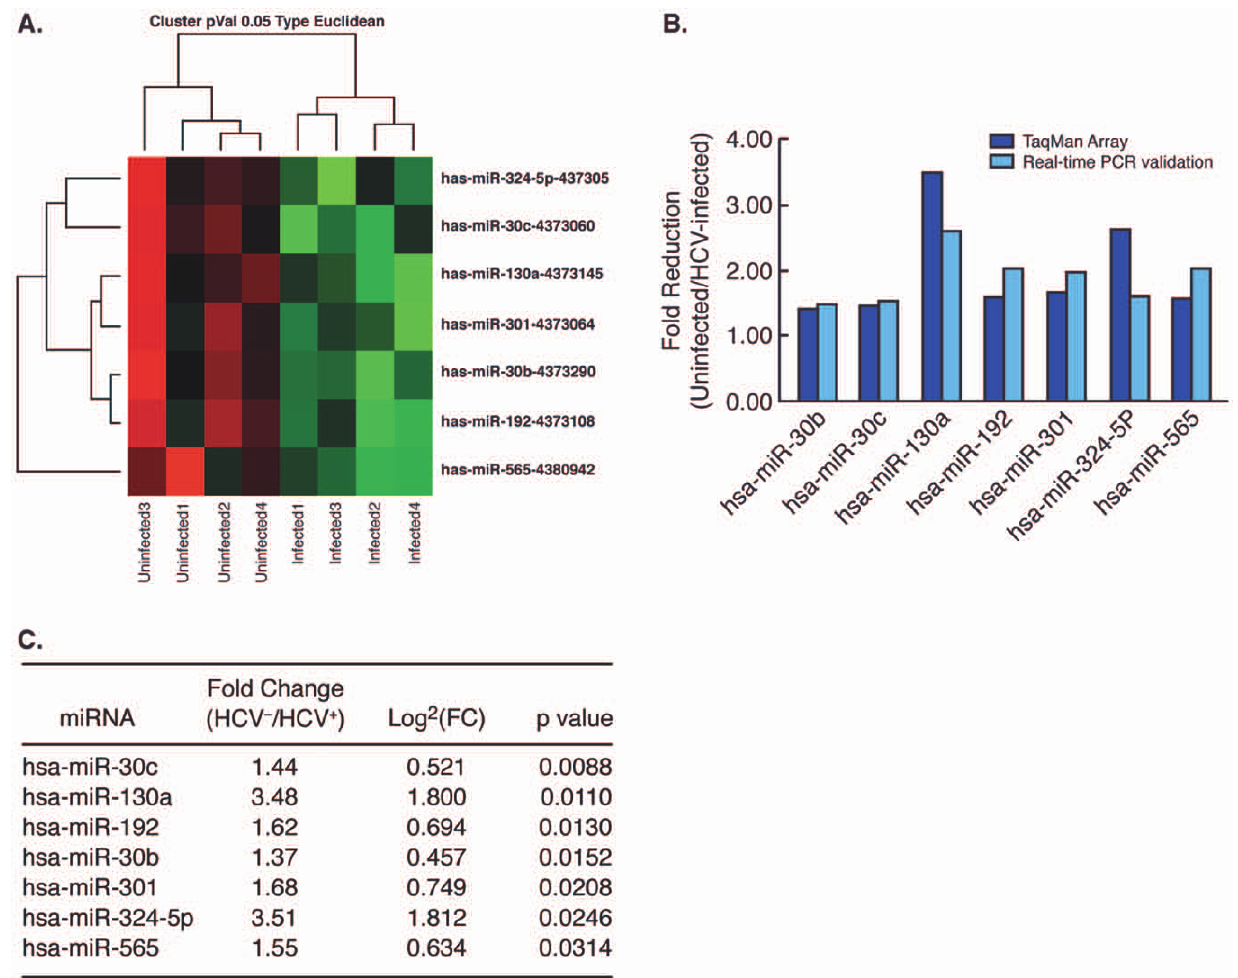
Figure 1. MiRNA expression and validation in HCV-infected Huh7.5 cells. (A) Heat map of differentially expressed miRNAs in uninfected and HCV-infected Huh7.5 cells using a continuous HCV culture system. Red indicates up-regulation of expression and green indicates down-regulation of expression. Seven miRNAs were down-regulated in HCV infection (p value , 0.05). (B) Quantitative RTPCR (q-RTPCR) validation of differentially expressed miRNAs. (C) Specific fold change (FC) values in differentially expressed miRNAs in HCV infected Huh7.5 cells ranked by p-value.